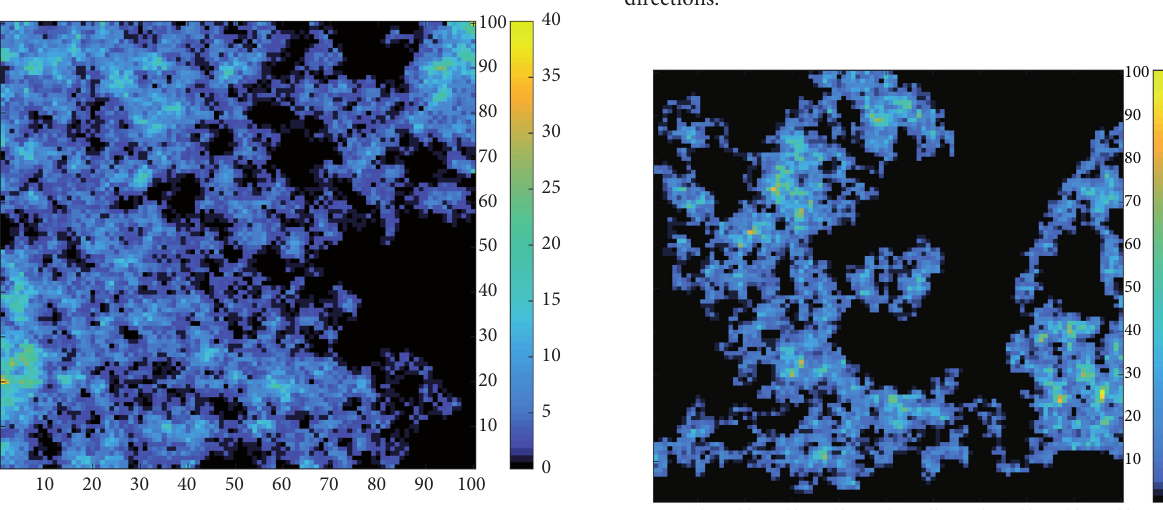
Figure 14: Color-coded grid coverage for 35,000 moves.